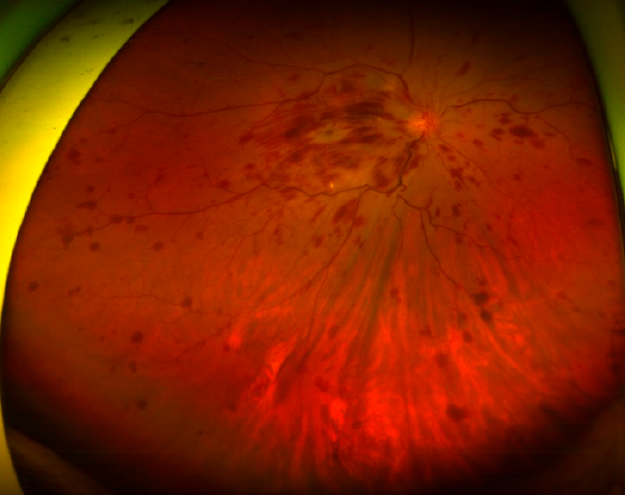
Figure 1. Funduscopic examination showing papilledema and flame-shaped hemorrhage over the four quadrants of the right eye. Medicina 2021 , 57 , 1238